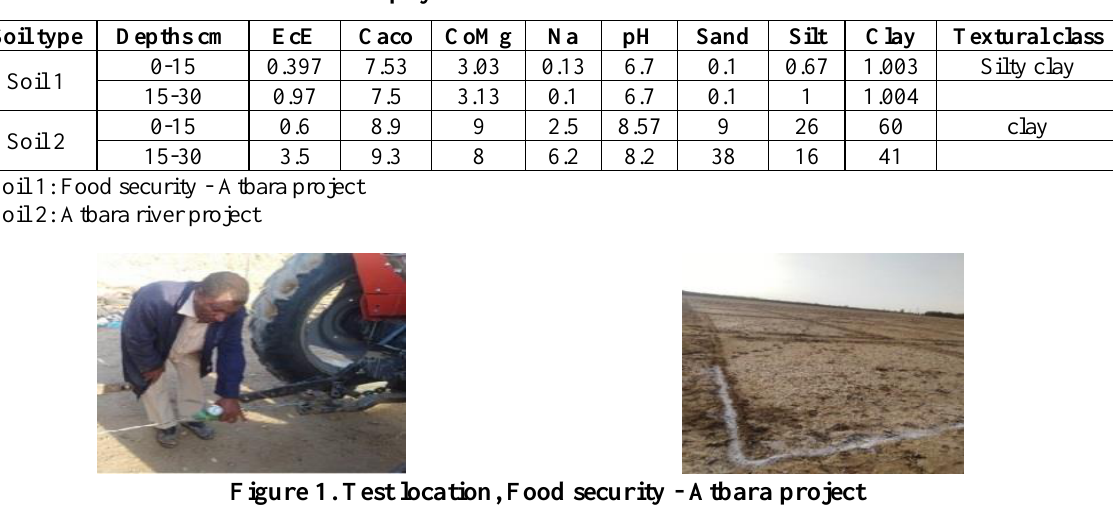
Table 1. Some physio-chemical characteristics of the soil